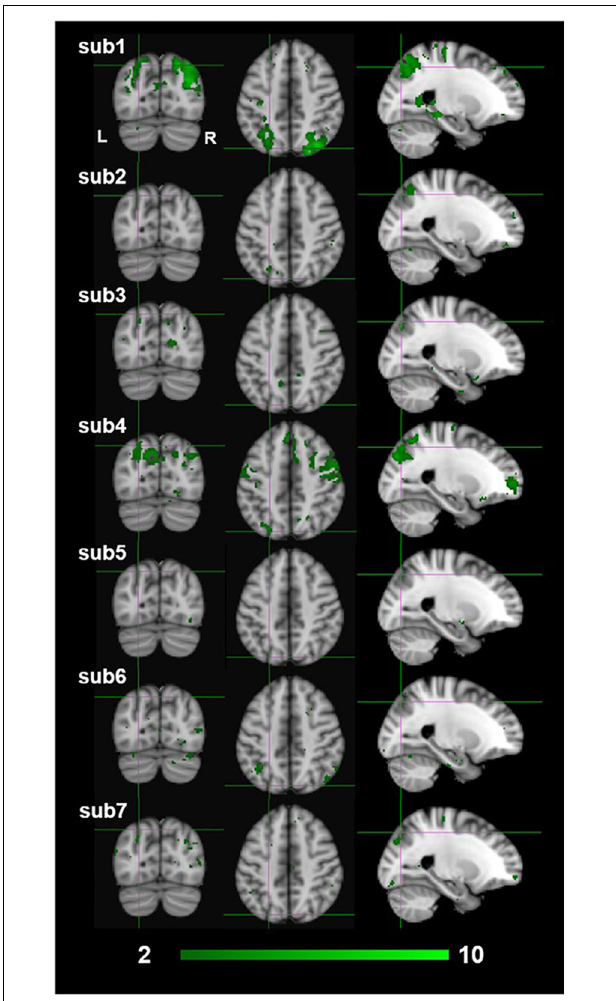
FIGURE 9 | Individual participants results by the third-level fixed effects contrast [(MaP INTACT > MaP SCRAMB ) > [BP INTACT > BP SCRAMB )] for monocular (green) stereopsis. The crosshairs represent the significantly overlapping region between monocular and binocular stereopsis [MNI coordinates: − 24, − 76, and